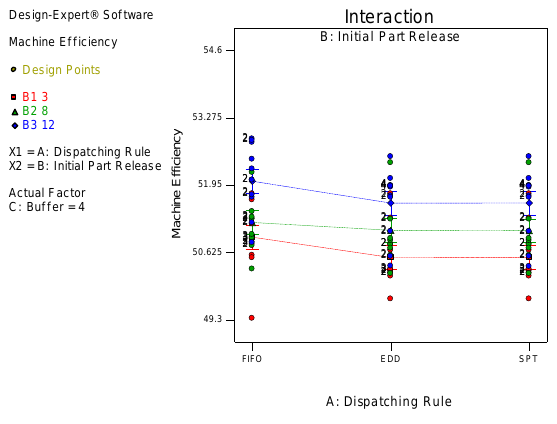
Figure 19. Machine efficiency initial part release & dispatching rule